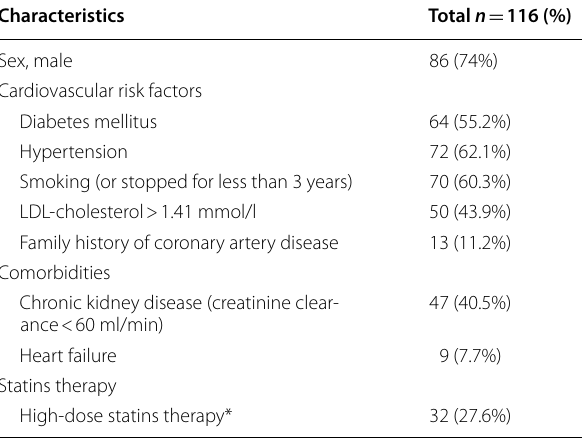
Table 1 Patients baseline